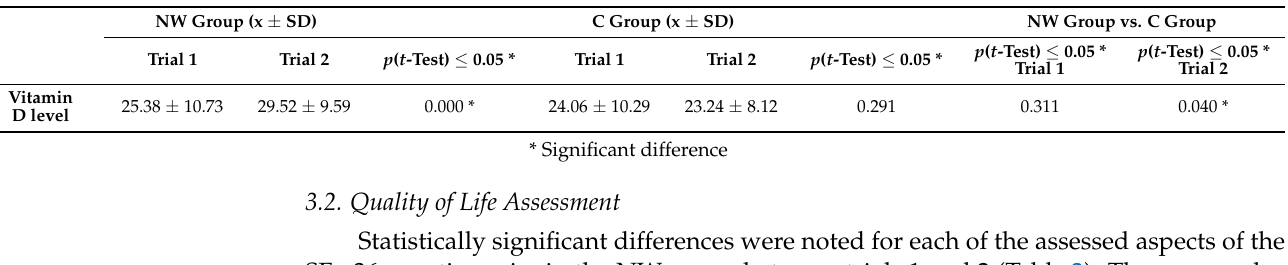
Table 1. Comparison of the mean values of the vitamin D level between NW and C groups.